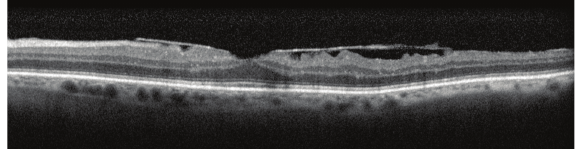
Figure 9: Pseudohole without any neurosensory defects.